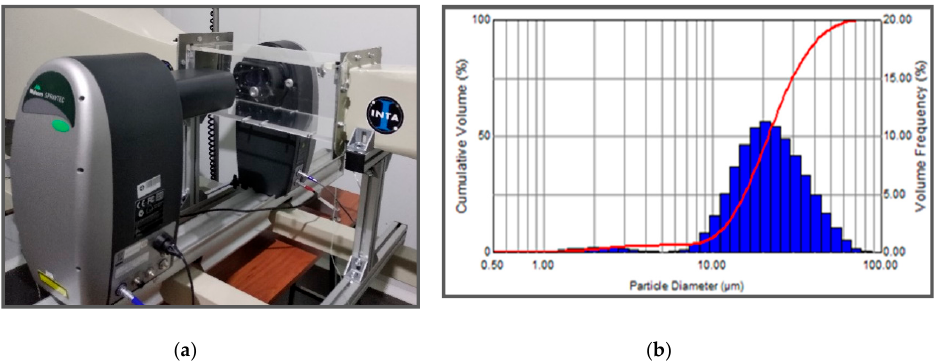
Figure 3. Image of the Spraytec system attached to the IWT testing chamber ( a ) and droplet size distribution obtained under the experimental testing conditions ( b ).